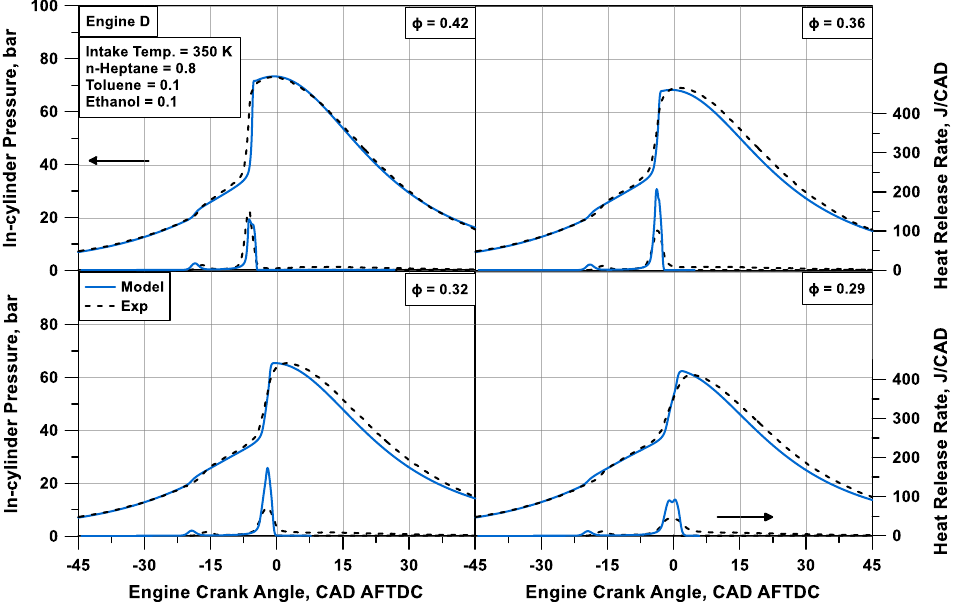
Figure 14. Numerical/experimental comparison of in-cylinder pressure traces and heat release rate profiles for Engine D ( Φ sweep).